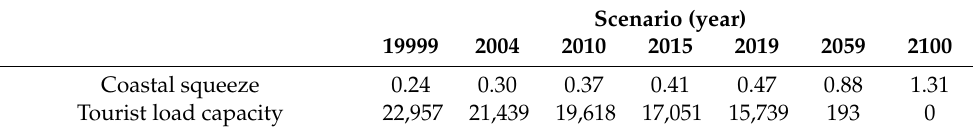
Table 14. Comparison of coastal squeeze and tourist load capacity in different